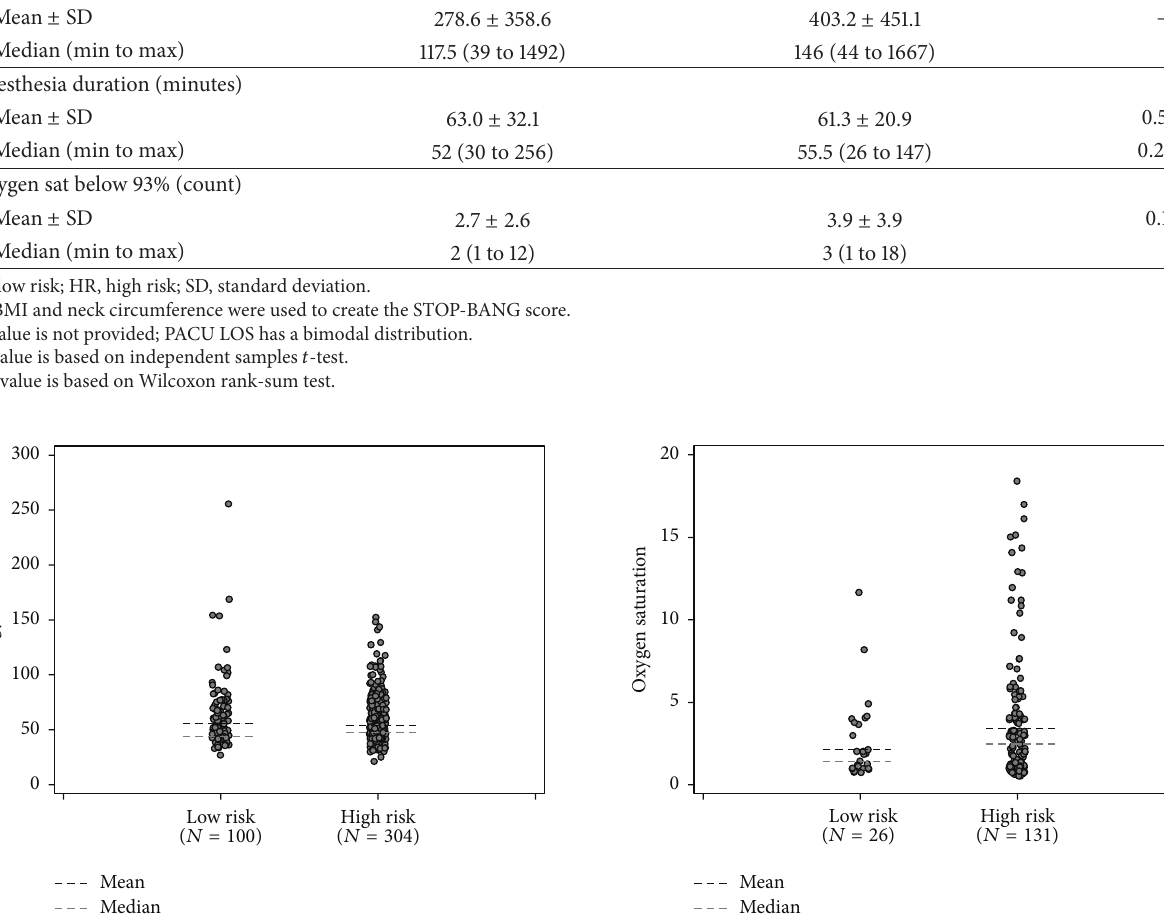
Figure 2: Procedure time by low and high risk patients based on STOP-BANG questionnaire.